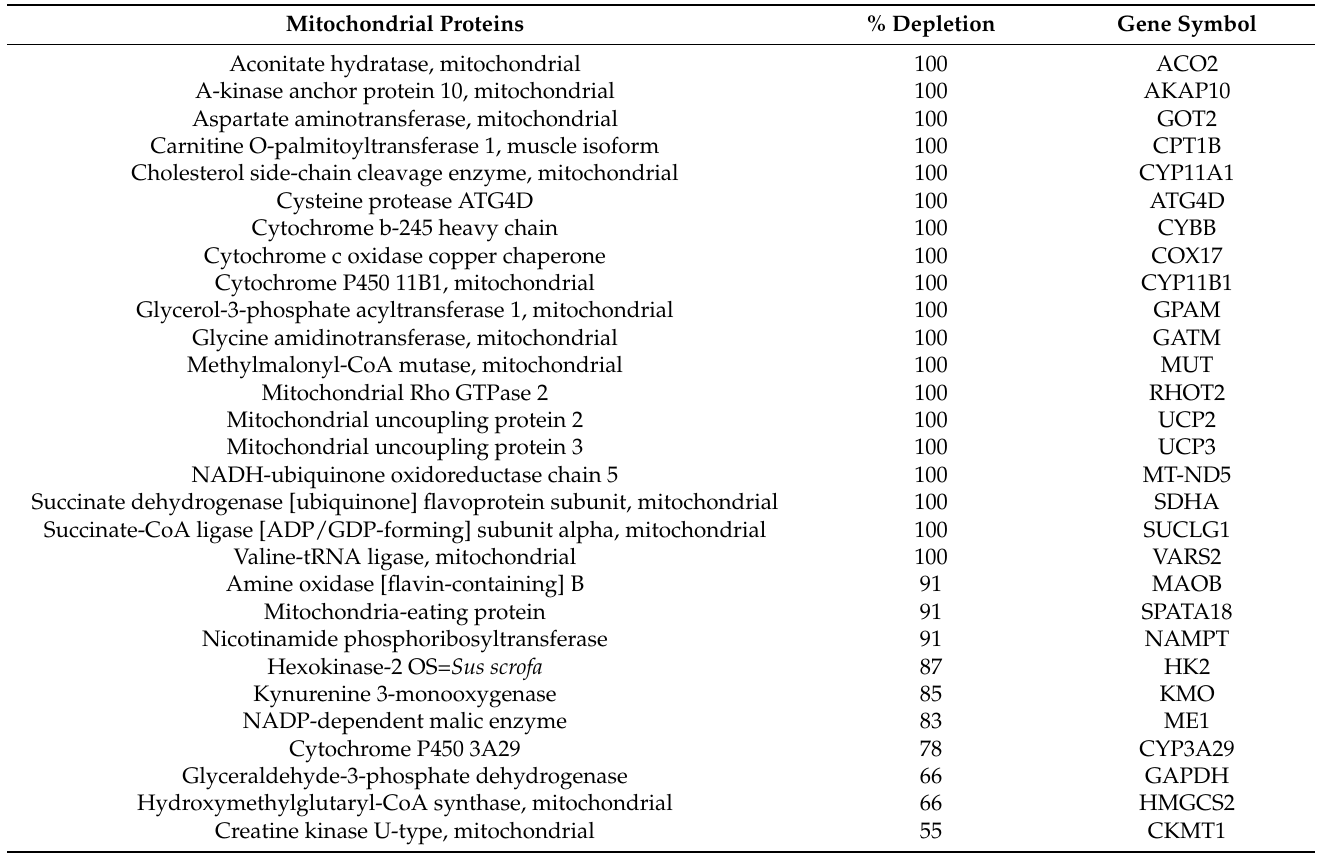
Table 3. Mitochondrial proteins depleted during